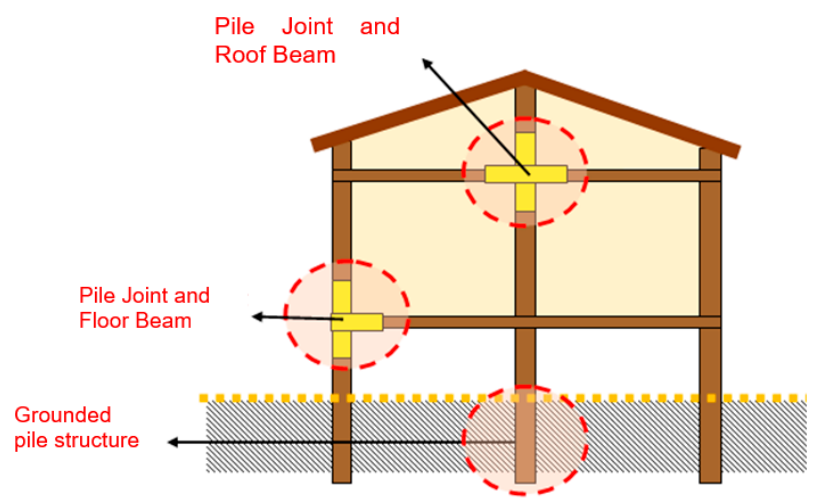
Figure 9. Illustration of the joint system of an Ammatoa vernacular house.